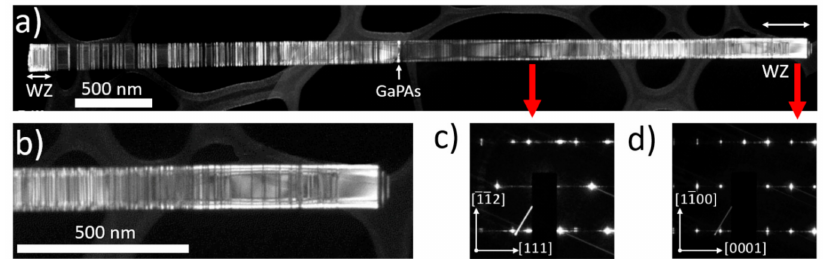
Figure 2. ( a ) dark-field TEM images obtained with WZ [1100] reflection, ( b ) zoomed dark-field TEM image and corresponding electron diffraction patterns acquired from ( c ) ZB and ( d ) WZ GaP NW segments, taken along [1 10] [1120] directions correspondingly. The inclined grey stripes appear due to the TEM CCD camera